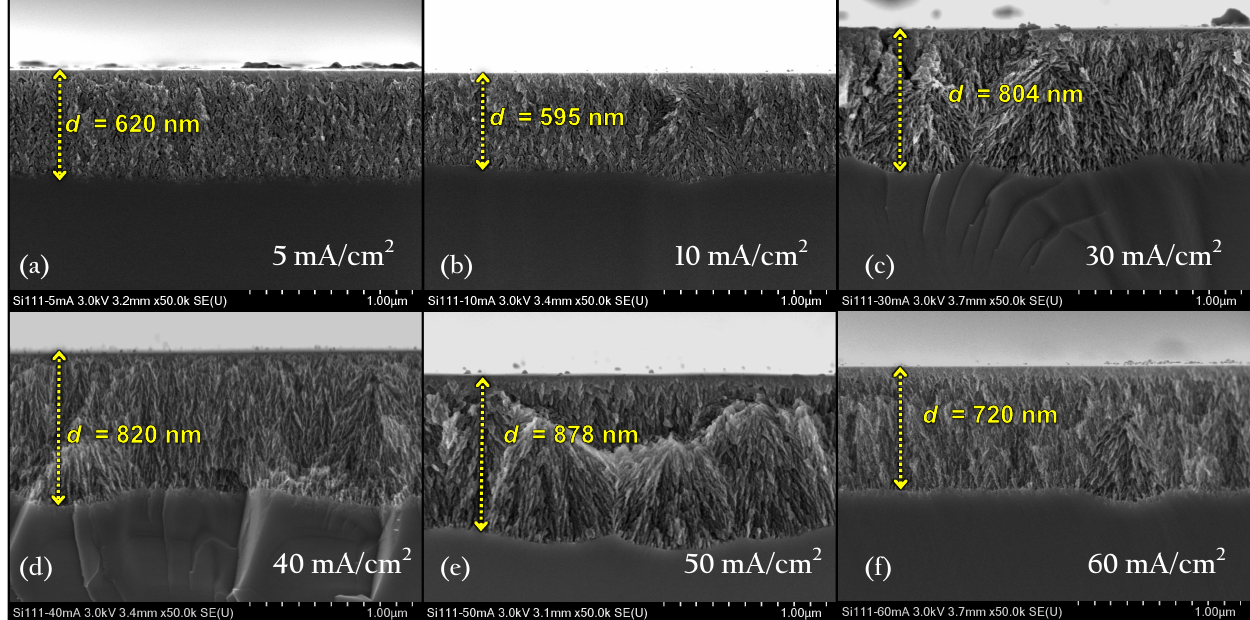
Figure 8. Cross section SEM images of PSi films at different anodizing current densities. ( a ) 5 mA/cm 2 , ( b ) 10 mA/cm 2 , ( c ) 30 mA/cm 2 , ( d ) 40 mA/cm 2 , ( e ) 50 mA/cm 2 , and ( f ) 60 mA/cm 2 . The micrographs show the interface between the PSi film and